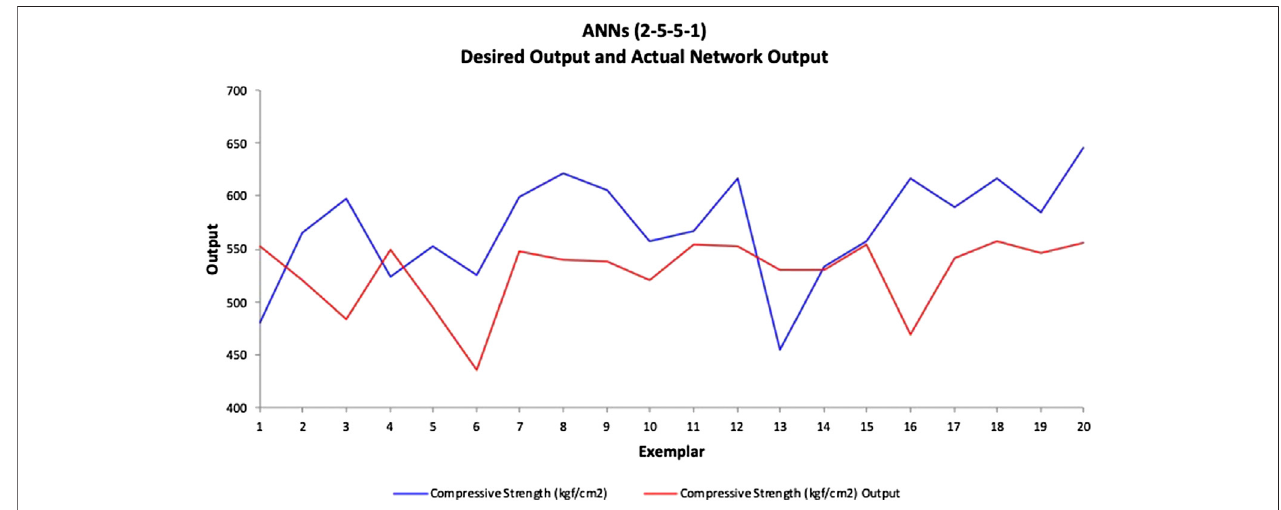
FIGURE 11 | ANN model (2-5-5 – 1) line